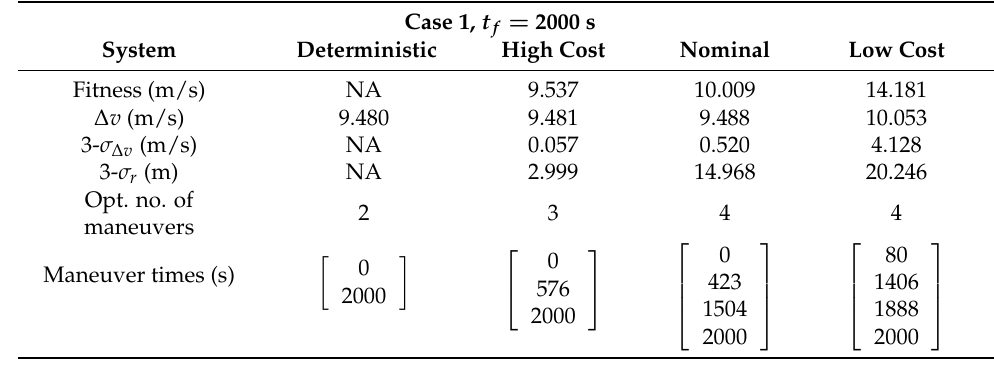
Figure 1. Optimal fitness function with respect to the number of maneuvers when t f = 2000 s. Table 3. Optimal trajectory results when t f = 2000